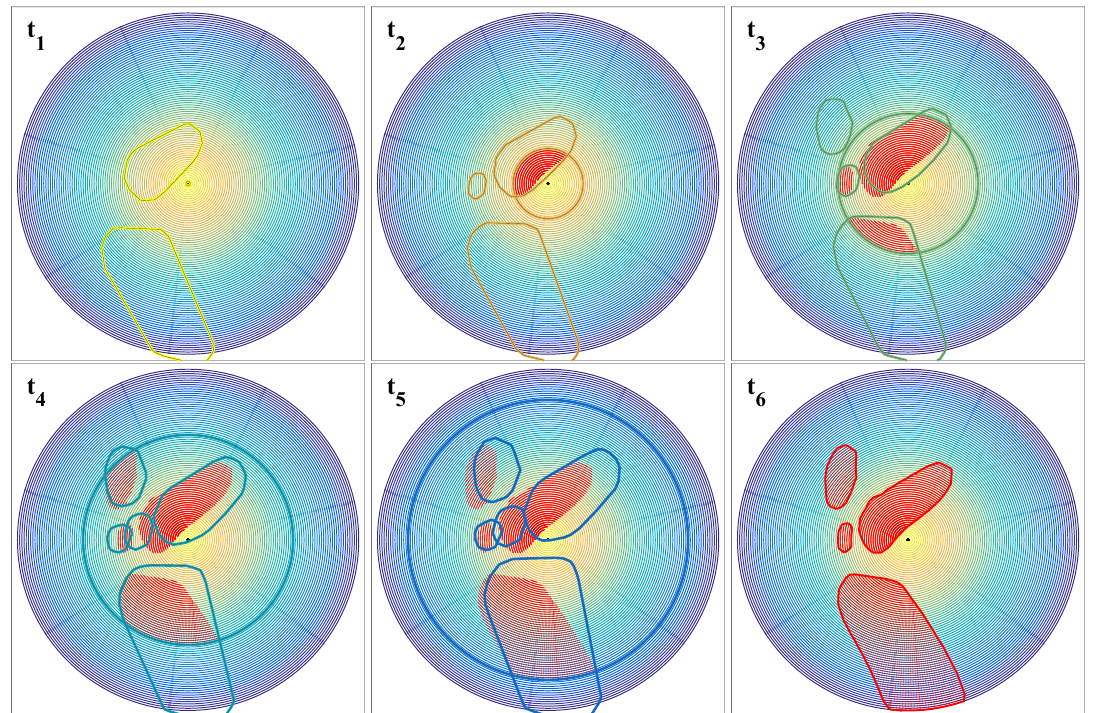
Figure 3. In this example the ground speed is equal to true airspeed. The evolution of estimated conflict areas is illustrated at six points in time ( t 1 – t 6 ). For each time, the estimated future states (highlighted isochrone circle) in conflict with contemporaneous expected thunderstorms (varying polygon shapes) are marked in red. This results in the final shape of the ECAs shown at t 6 .